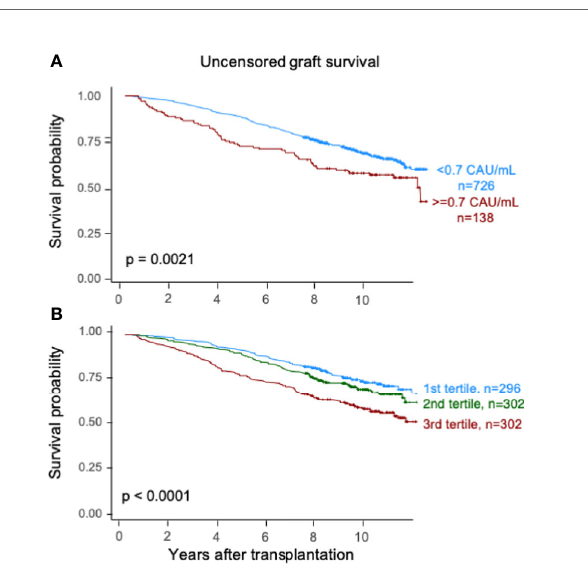
FIGURE 3 | Kaplan – Meier estimates of uncensored graft survival after kidney transplantation according to plasma terminal C5b-9 complement complex (TCC) concentration 10 weeks after transplantation; (A) cut point of <0.7 CAU/ml and (B) tertiles.